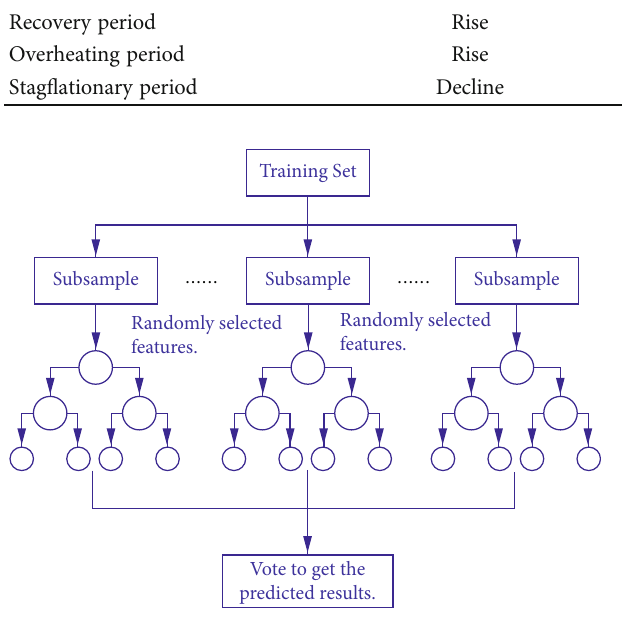
Figure 1: Random forest generation structure.